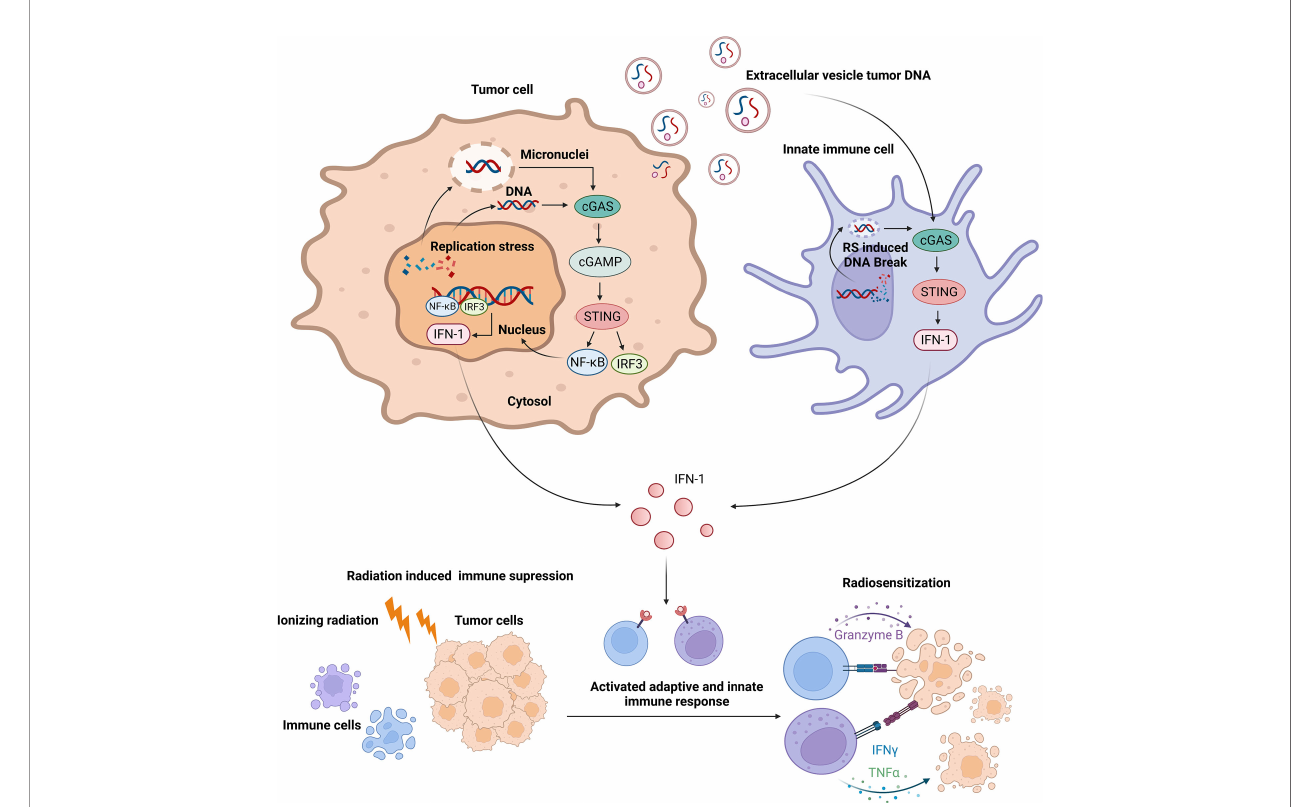
FIGURE 5 | Replication stress-induced activation of innate immune response enhances radiosensitivity via cyclic GMP-AMP synthase – STING